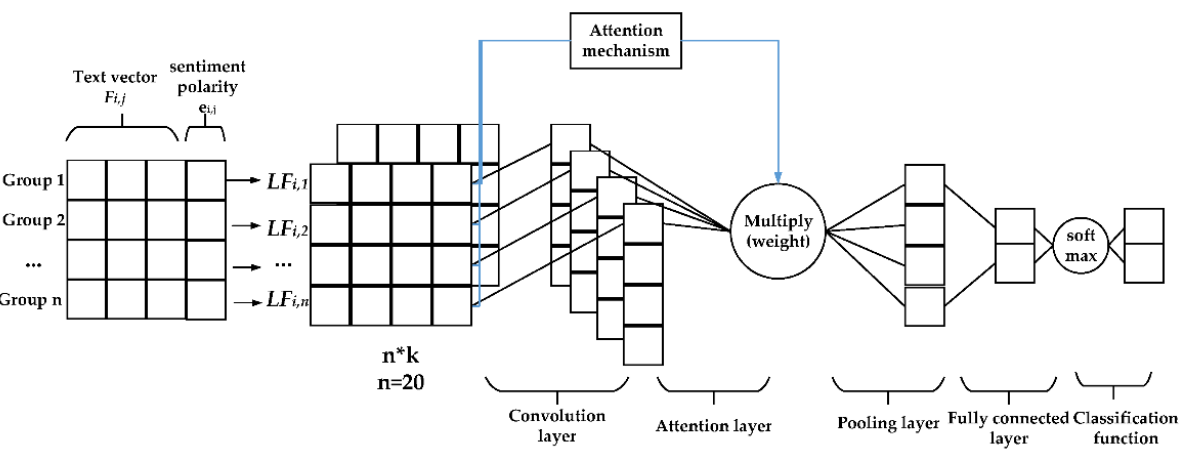
Figure 4. Convolutional neural network model with the attention mechanism.